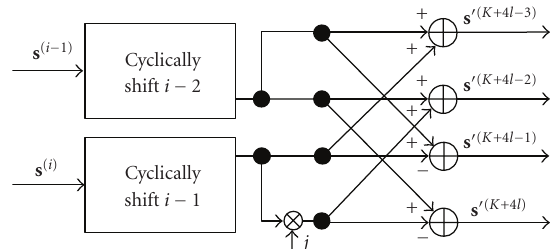
Figure 3: Algorithm of improved cyclically shifting for generate new